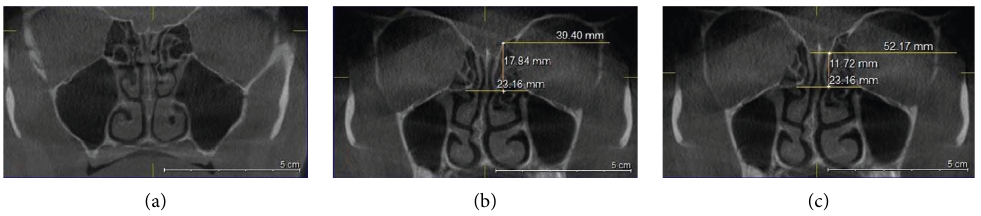
Figure 8: (a) Coronal plan of CBCT demonstrating type 1 TMS classification on the left side. (b) OFL-ER measurement and (c) OFL-CP measurement coronal plan of CBCT.